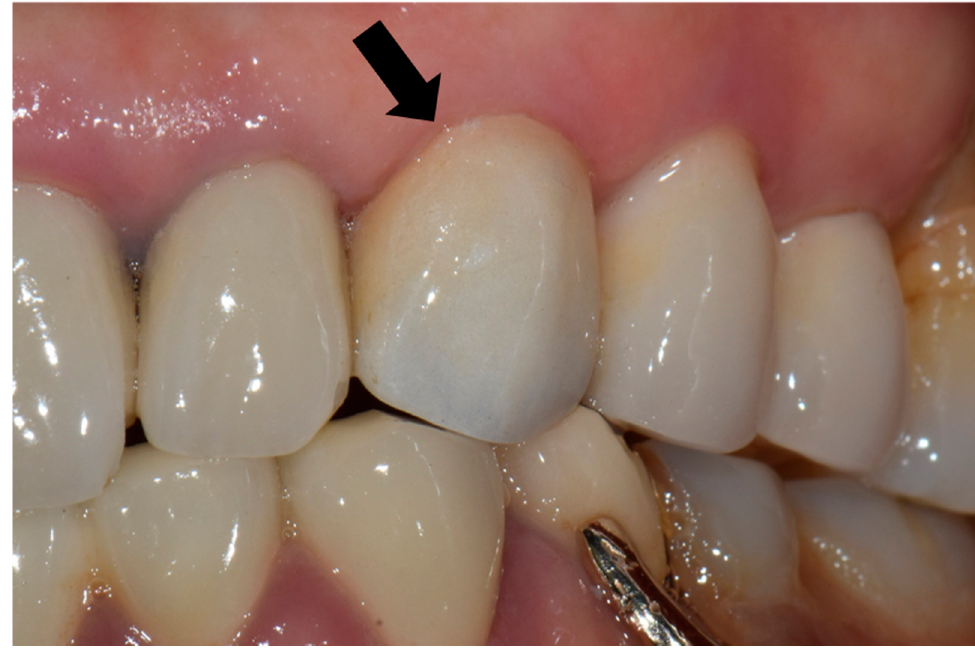
Figure 1. Fully sintered (Y, Nb)-TZP (tetragonal zirconia polycrystal) crown was placed on the maxillary left canine (black arrow).